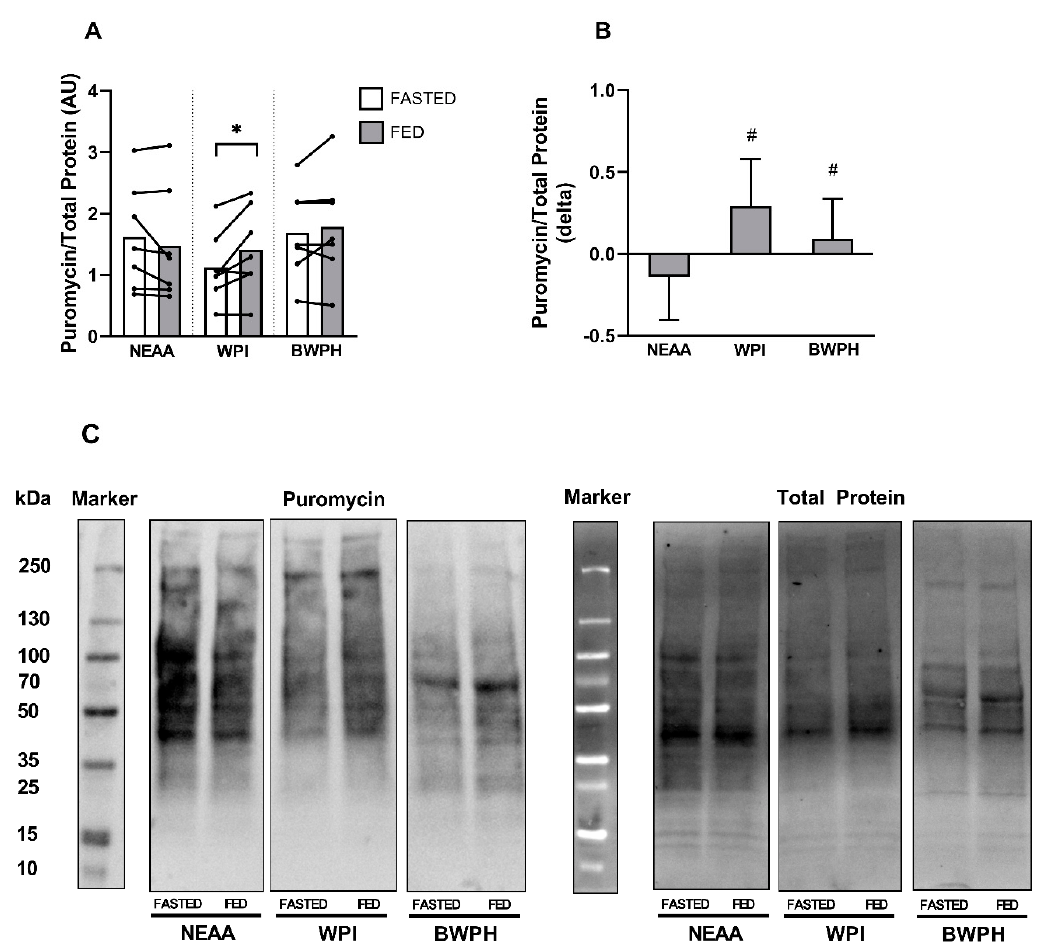
Figure 3. Puromycin incorporation in response to treatment with ex vivo (FASTED and FED) human-conditioned serum ( n = 7). ( A ) Densitometric analysis of puromycin incorporation in the FASTED and FED state in response to non-essential amino acids (NEAA), whey protein isolate (WPI), and blue whiting protein hydrolysate (BWPH). ( B ) Puromycin incorporation expressed as difference scores (delta). ( C ) Representative immunoblot of puromycin incorporation and total protein (loading control). Data reported as mean ± SD. * Significantly different between FASTED and FED serum; # significantly different compared with NEAA.